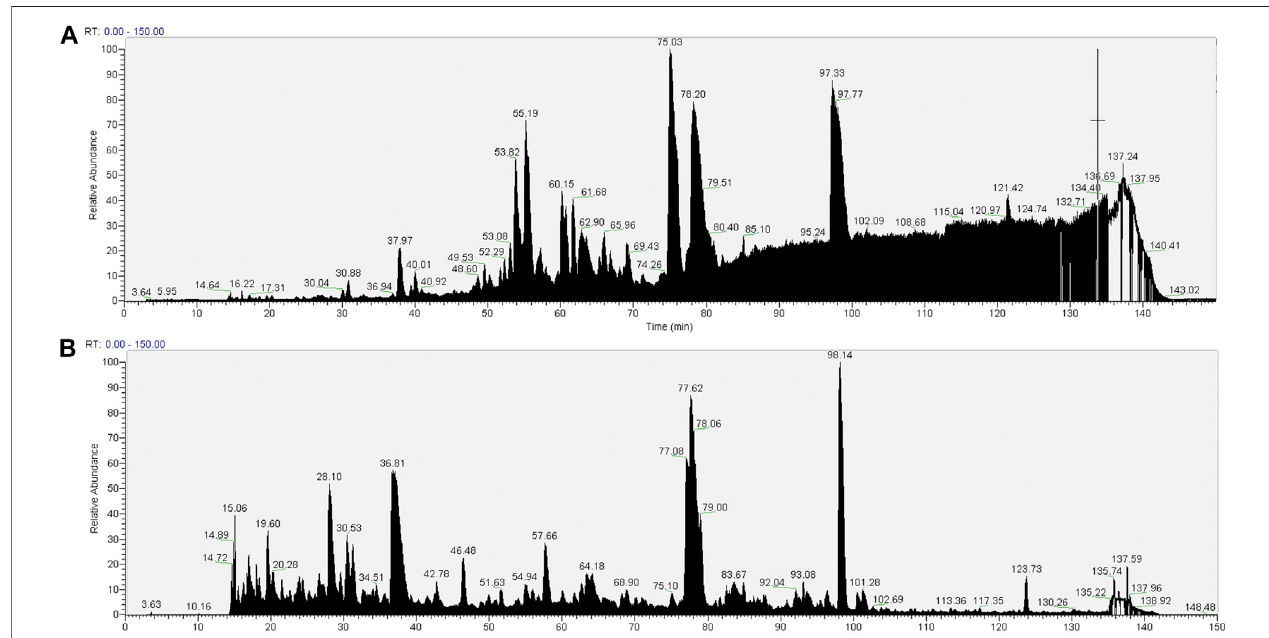
FIGURE3 | Total ion chromatogramsofmaterial associatedwith NeutrAvidinbeads following wash procedure 1(beadswere washed with 4 × 1 mlPBS). Material associated with beads in the pull-downs from 1.5% SMA supernatants or RIPA supernatants were reduced, alkylated, and then digested from the beads with trypsin (2.5 µg trypsin; 37 ° C, overnight). The resulting peptides weredesaltedusing aSepPak cartridge. Peptides were fractionated on an Acclaim PepMap C18 reverse phase analytical column over a 150-min organic gradient, using seven gradient segments. TICs for (A) material in pull-downs from SMA-extracted supernatants and (B) material in pull-downs from RIPA-extracted supernatants are